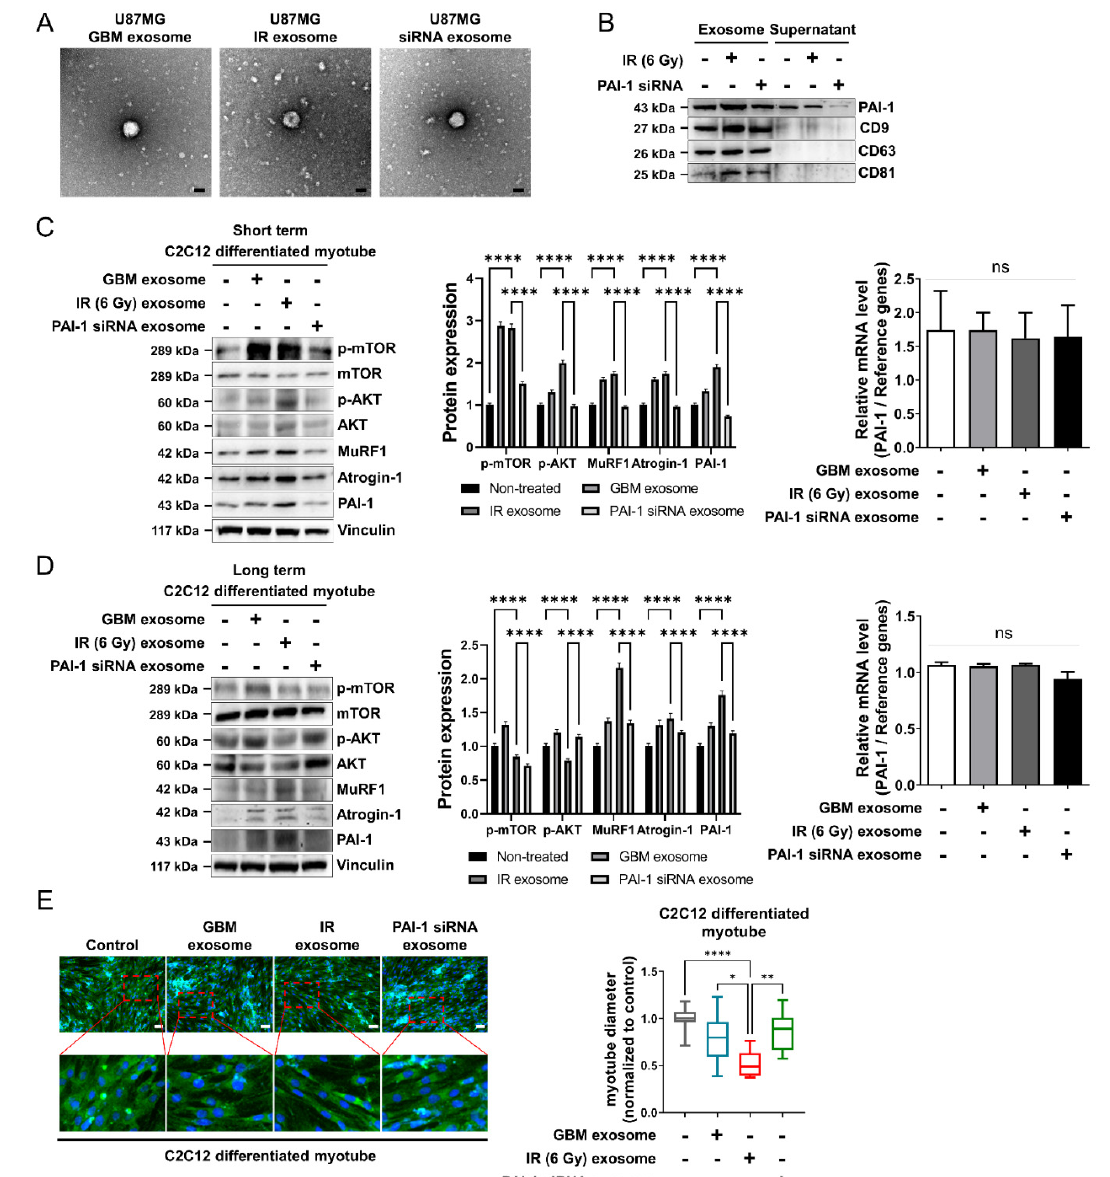
Figure 4. Ionizing radiation-induced PAI-1 from GBM cells was carried by exosomes and induced cachexia. ( A ) Representative images of U87MG exosomes taken by the transmission electron micrograph (TEM), Scale bar, 100 nm. ( B ) PAI-1 protein was highly expressed in exosome fraction. Conditioned medium (CM) from U87MG cells was collected and ultracentrifugation method was performed to isolate exosomes and supernatant. Western blotting was performed to detect the expression of PAI-1 protein and CD9, CD63, CD81 in exosome and supernatant with equal amounts of protein. ( C , D ) The protein expression of muscle protein synthesis (p-mTOR, p-AKT), muscle protein degradation (MuRF1, Atrogin-1) related proteins, and the PAI-1 protein in C2C12 differentiated myotube cell treated with the U87MG exosome in the short-term or long-term were assessed by western blot (left panel), p-mTOR, p-AKT, MuRF1, Atrogin-1, PAI-1 protein were quantified (middle panel), mRNA expressions change of PAI-1 in C2C12 differentiated myotube treated with U87MG exosome in the short-term or long-term were assessed by qRT-PCR (right panel). ( E ) C2C12 differentiated myotube cells treated with U87MG exosome were stained with MHCI (green) and DAPI (blue) to measure myotube diameter. Scale bar, 10 μ m. Statistical analysis was performed with one-way ANOVA plus Tukey’s multiple comparisons test. ns: nonsignificant, * p < 0.05, ** p < 0.01, **** p < 0.0001.